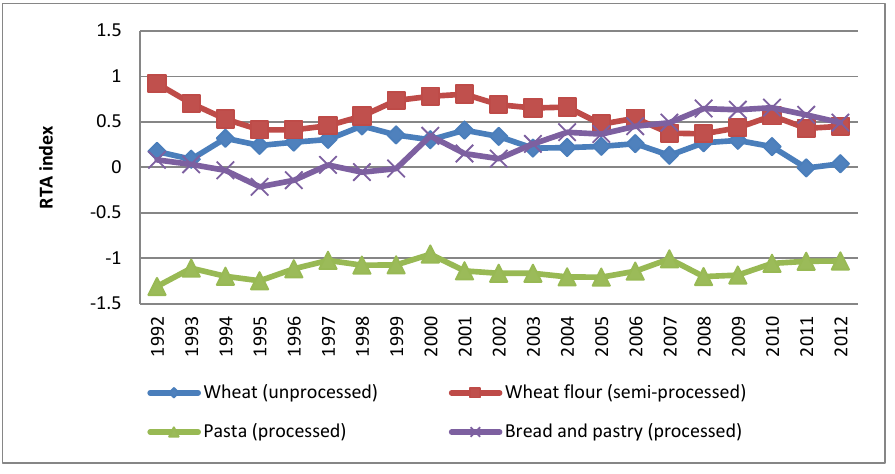
FIGURE A5: Trends in RTA index values for unprocessed, semi-processed and processed wheat in Germany